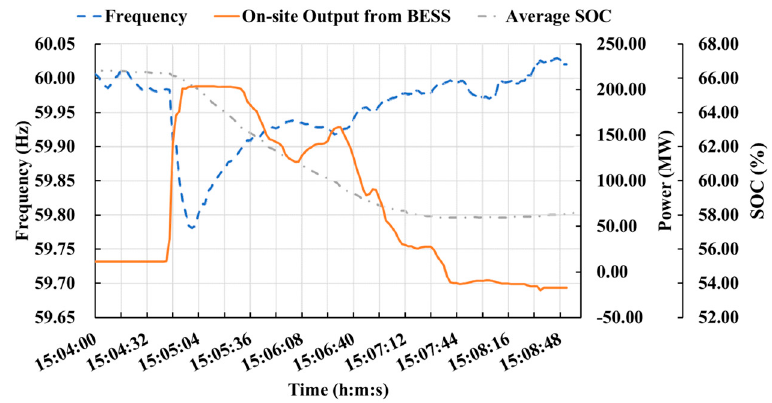
Figure 13. Operation result response to a large generator trip (Case 1).